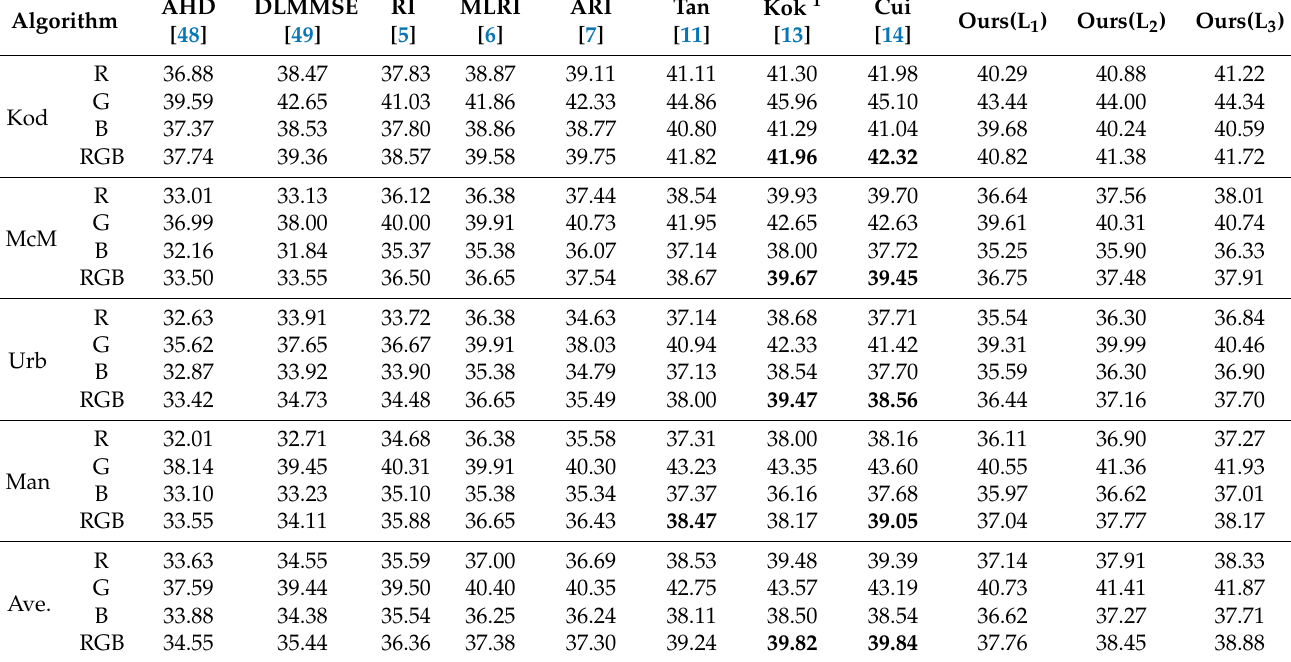
Each algorithm was tested on four datasets to get the PSNR s (for each single color) and the CPSNR s (for the whole image of three colors). Due to their difference in padding and other pre-processing strategies, a 5-pixel at each edge was ignored when testing the PSNR values. The results are shown in Table 3. Table 3. The PSNR values (dB) of each channel (R, G, B) and CPSNR s of the whole image (RGB) of 9 demosaicking algorithms on Kodak, McMaster, Urban100, Manga109 datasets and the final average values of them. The bolded two methods in each section are those that achieve better performance among all